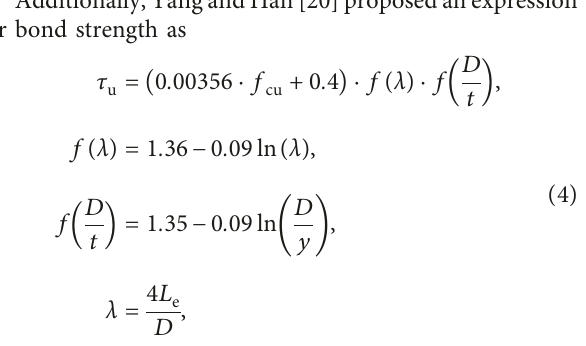
Figure 9: Typical bond stress-slip of different concrete strengths.